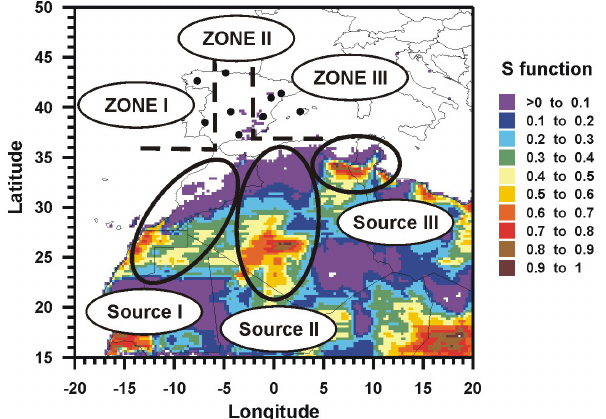
Figure 9. Zones of study and source areas represented over the geographic distribution of the dust source function S (Ginoux et al., 2001). Data obtained from the Atmospheric Physics, Chemistry and Climate Data of the GFDL-NOAA (http://www.gfdl.noaa.gov/